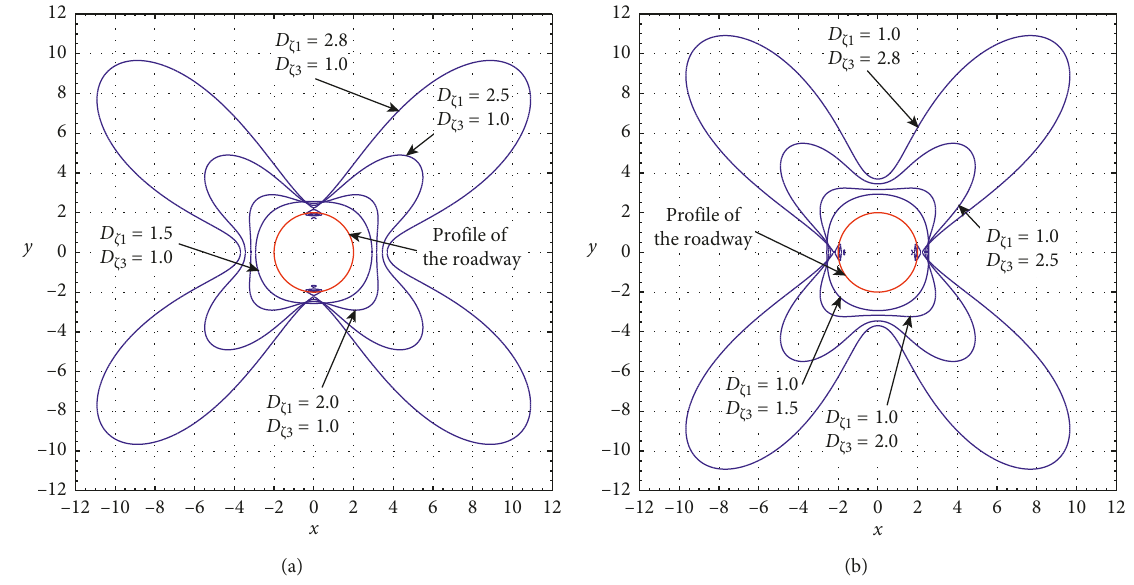
Figure 5: The plastic zone morphology of the deep roadway (a) influenced by vertical mining-induced pressure and (b) influenced by horizontal mining-induced